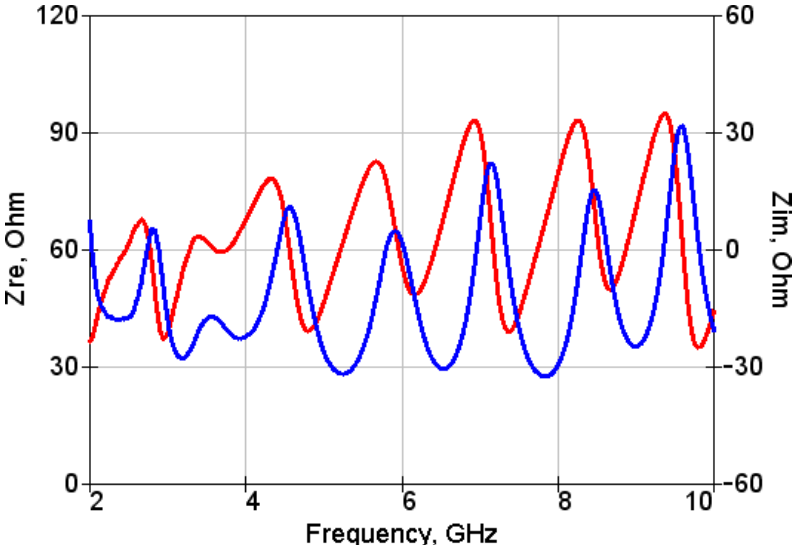
Figure 8. The real (red, left axis) and simulated signals (blue, right axis) of developed antenna (Figures 2 and 3)